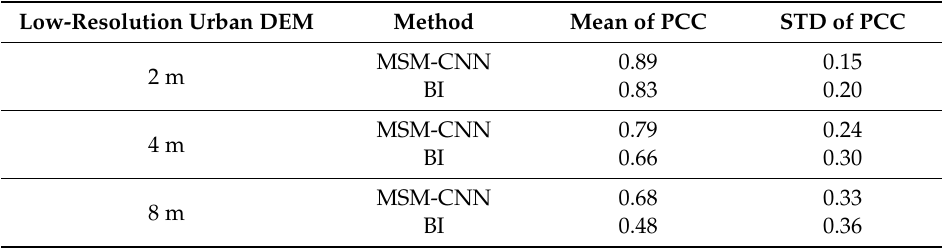
Table 3. Morphological accuracy statistics of road-profile variance.